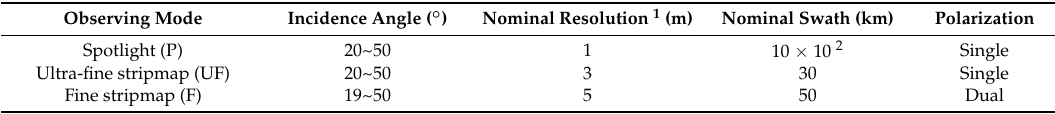
Table 1. Observing modes of Gaofen-3